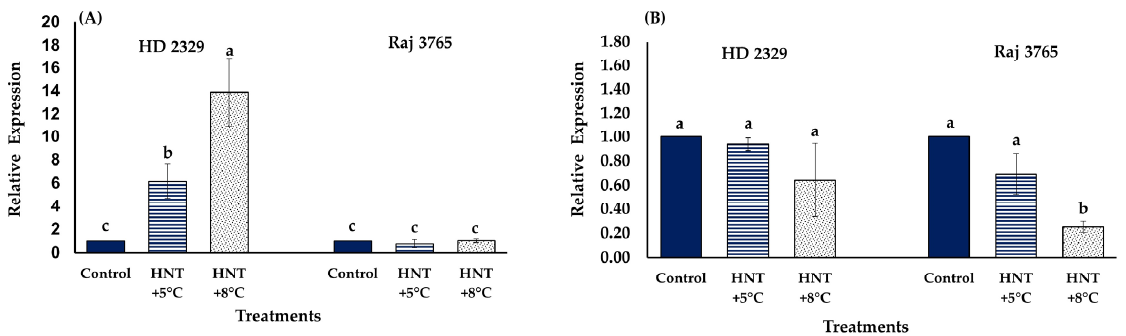
Figure 12. Effect of HNT on relative expression of ( A ) ABA 8 ′ -hydroxylase 1 ( TaCYP707A1 ) and ( B ) ent-kaurene oxidase 2 ( TaKO2 ) gene in pistil of wheat genotypes HD 2329 (sensitive) and Raj 3765 (tolerant) under control, HNT (+5 °C) and HNT (+8 °C) conditions. Bars represent mean ± SE. Bars with common letter are not significantly different between temperature treatments in a genotype at p < 0.05.